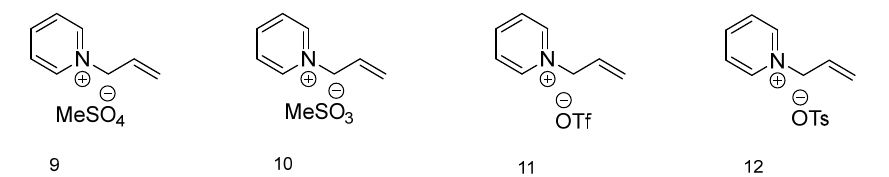
Figure 3. Structures of ionic liquids based on 1-allylpyridinium cation.